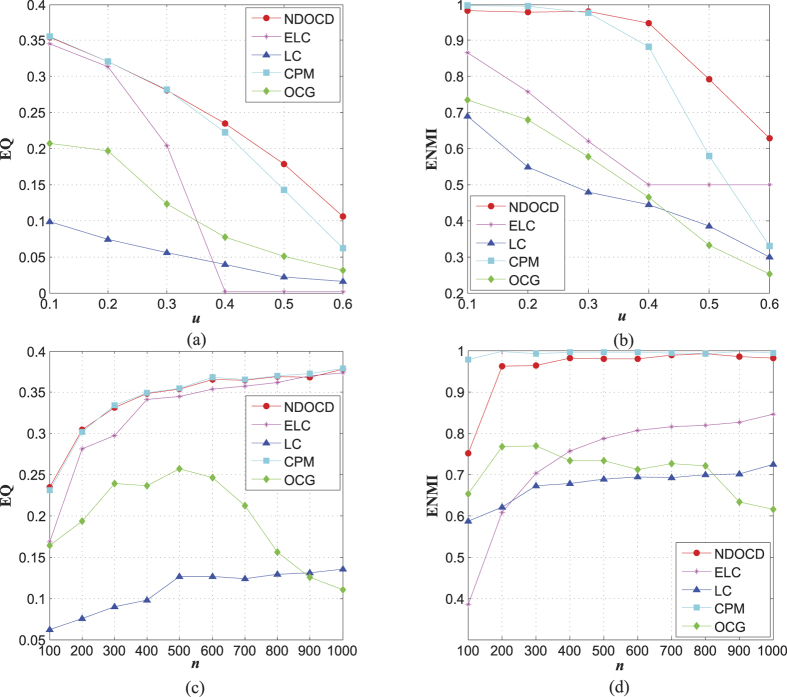
The effects of mixing parameter u and network size n on synthetic networks.(a) EQ for networks with n = 500, k = 25, kmax = 50, u = 0.1 ~ 0.6, τ1 = 2, τ2 = 1, cmax = 50, cmin = 10, om = 2, on/n = 10%, (b) ENMI for networks with n = 500, k = 25, kmax = 50, u = 0.1 ~ 0.6, τ1 = 2, τ2 = 1, cmax = 50, cmin = 10, om = 2, on/n = 10%, (c) EQ for networks with n = 100 ~ 1000, k = 25, kmax = 50, u = 0.1, τ1 = 2, τ2 = 1, cmax = 50, cmin = 10, om = 2, on/n = 10%, (d) ENMI for networks with n = 100 ~ 1000, k = 25, kmax = 50, u = 0.1, τ1 = 2, τ2 = 1, cmax = 50, cmin = 10, om = 2, on/n = 10%.